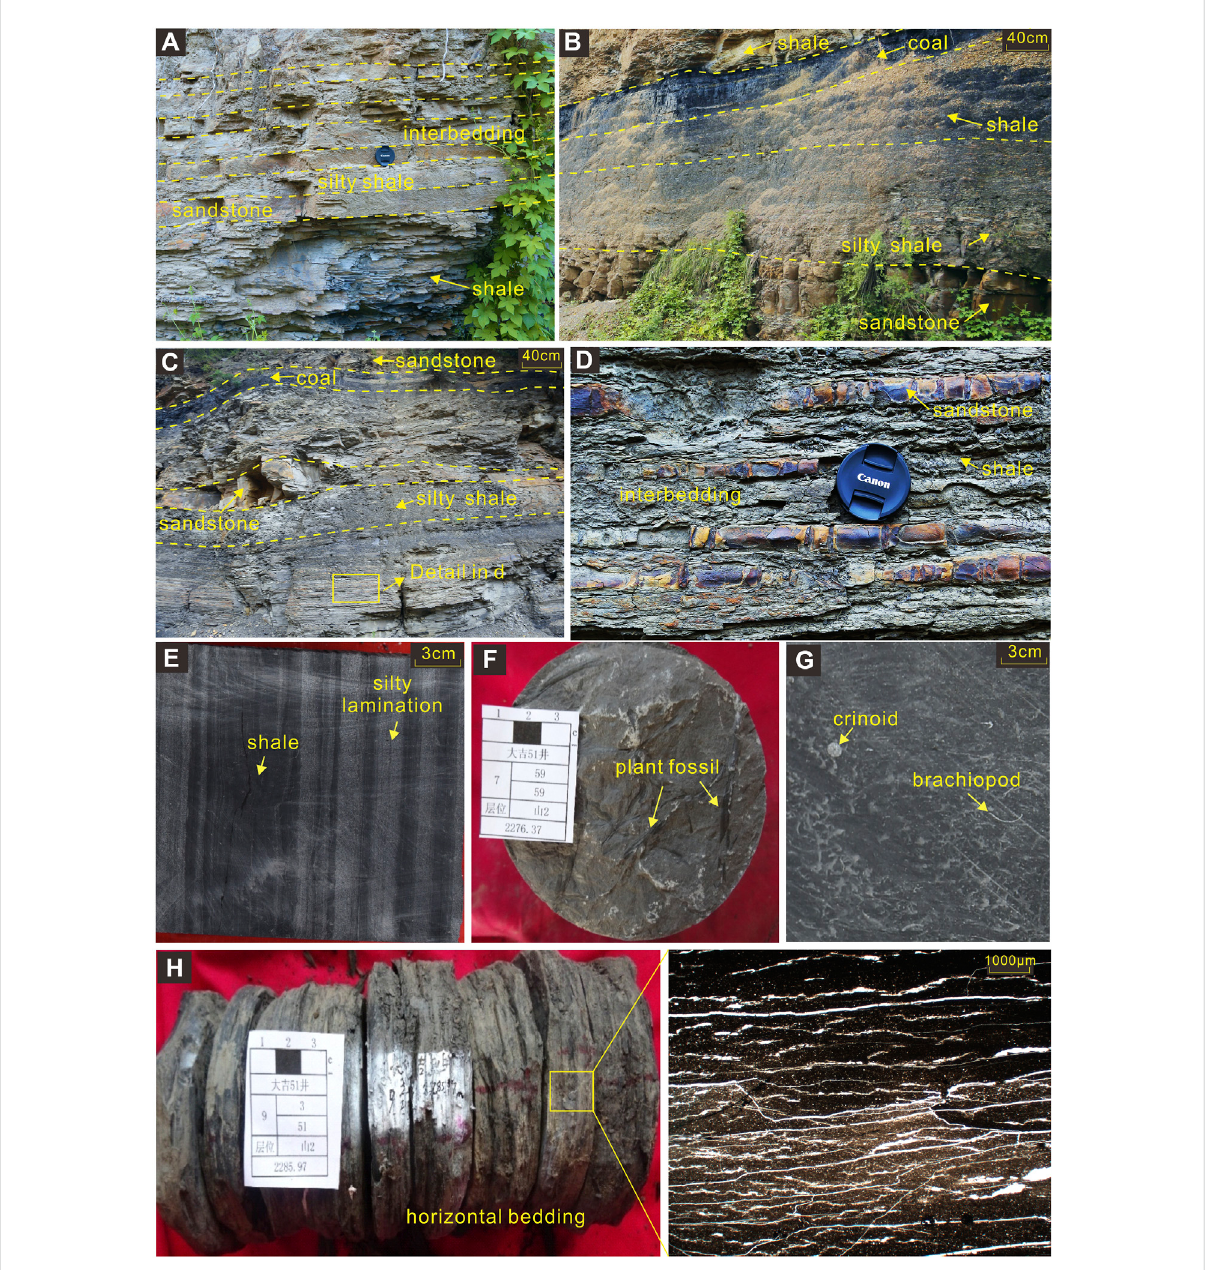
FIGURE 6 Sedimentary characteristics for Shanxi Formation Shan-2 Member from outcrops and cores in the eastern Ordos Basin. (A) Frequent thin interbedsofsandstoneandsiltyshale,withthelowerpartbeingshale,Shan-2Member,Taitououtcrop. (B,C) Interbeddingofshale,coal,sandyshale, and sandstone, Shan-2 Member, Taitou outcrop. (D) Frequent interbedding of shale and thin sandstone, Shan-2 Member, Taitou outcrop. (E) Shale and silty lamination interbedding and horizontal bedding, Well DJ3-4, 2,123.2 m, Section 4. (F) Gray silty shale containing plant debris, Well DJ51, 2,276.37 m,Section3. (G) Gray – black shale containingmarinebioclastsincluding crinoids andbrachiopods, Well DJ51, 2,294.89 m,Section1. (H) Gray – black shale and horizontal bedding, Well DJ51, 2,285.97 m, Section